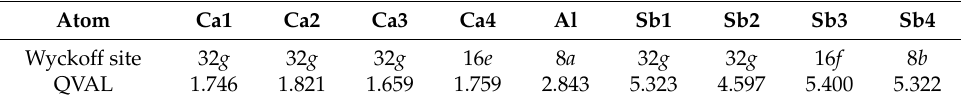
Table 3. QVAL values for each atomic site of Ca 14 AlSb 11